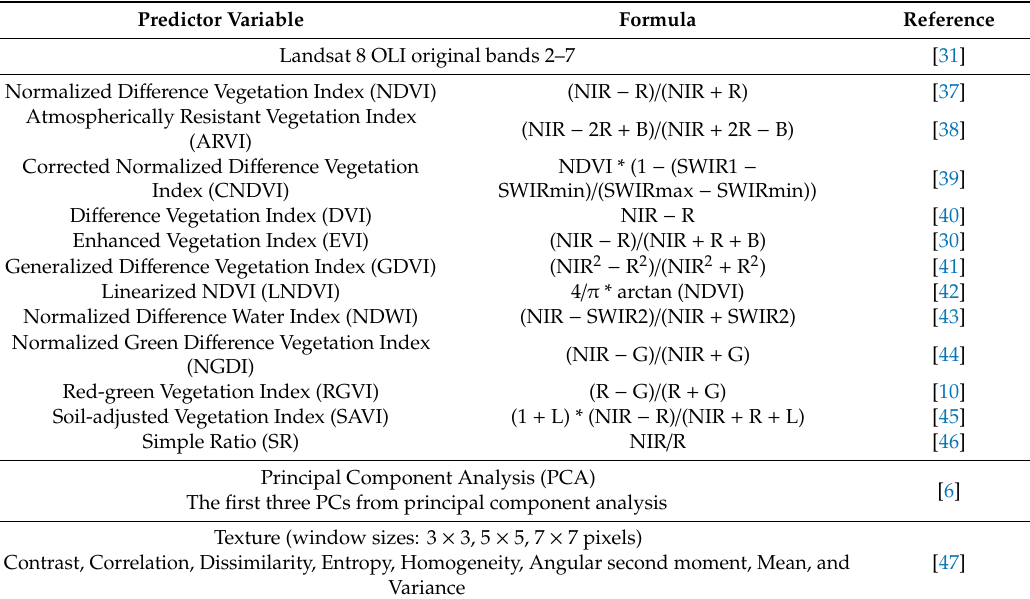
Table 3. Summary of the predictor